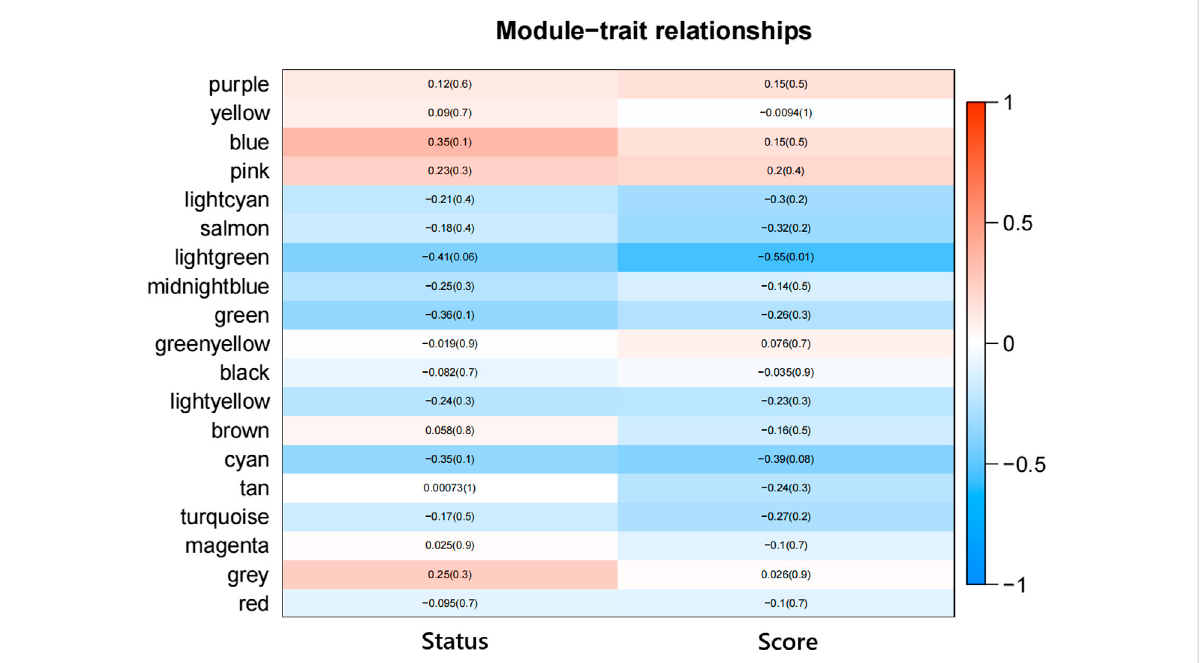
FIGURE 5 Heatmap of the correlation between module eigengenes and the FOLFIRI response of colon